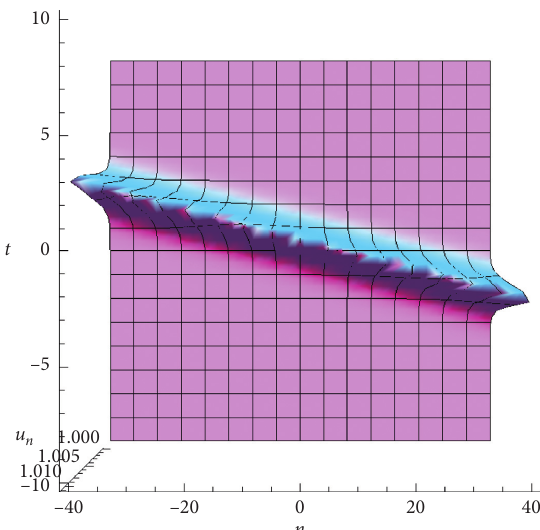
Figure 4: Spatiotemporal structure of semidiscrete one-soliton solution (69) with the parameters α ( 0 ) � 1, k � 3, and z c 1